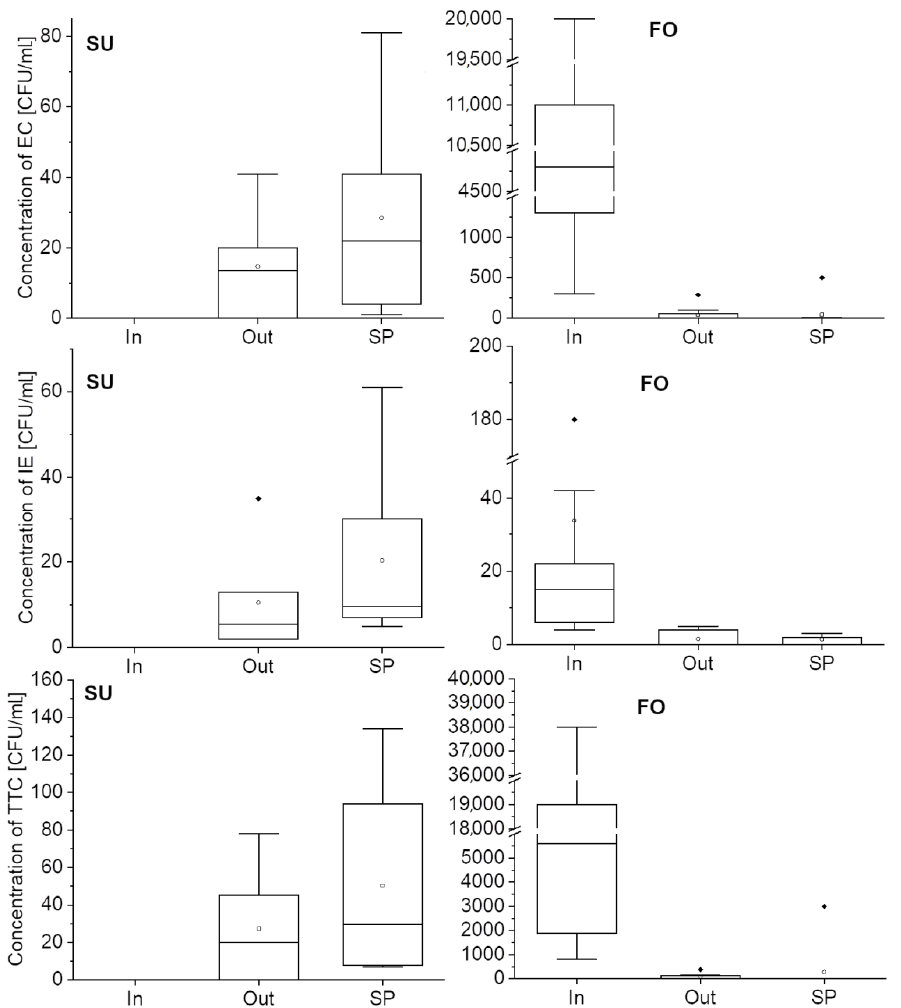
Figure 8. Pathogen concentration comparison during SU = start-up phase and FO = full-scale operation, In = inlet, Out = outlet, SP = stabilization pond.